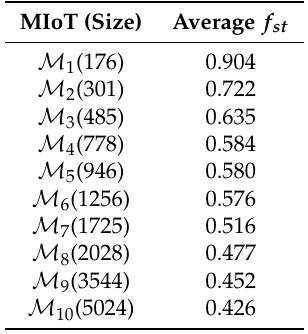
Table 11. Average values of f st against the size of MIoTs (unsupervised